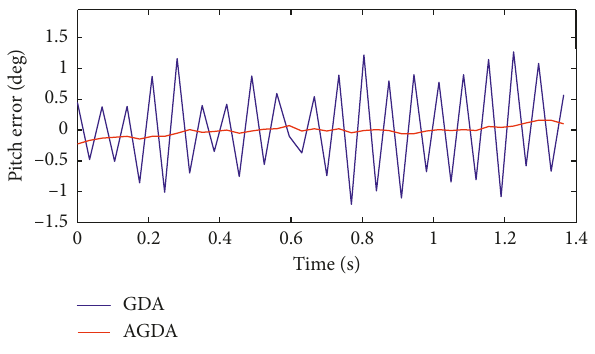
Figure 6: Pitch angle error results.